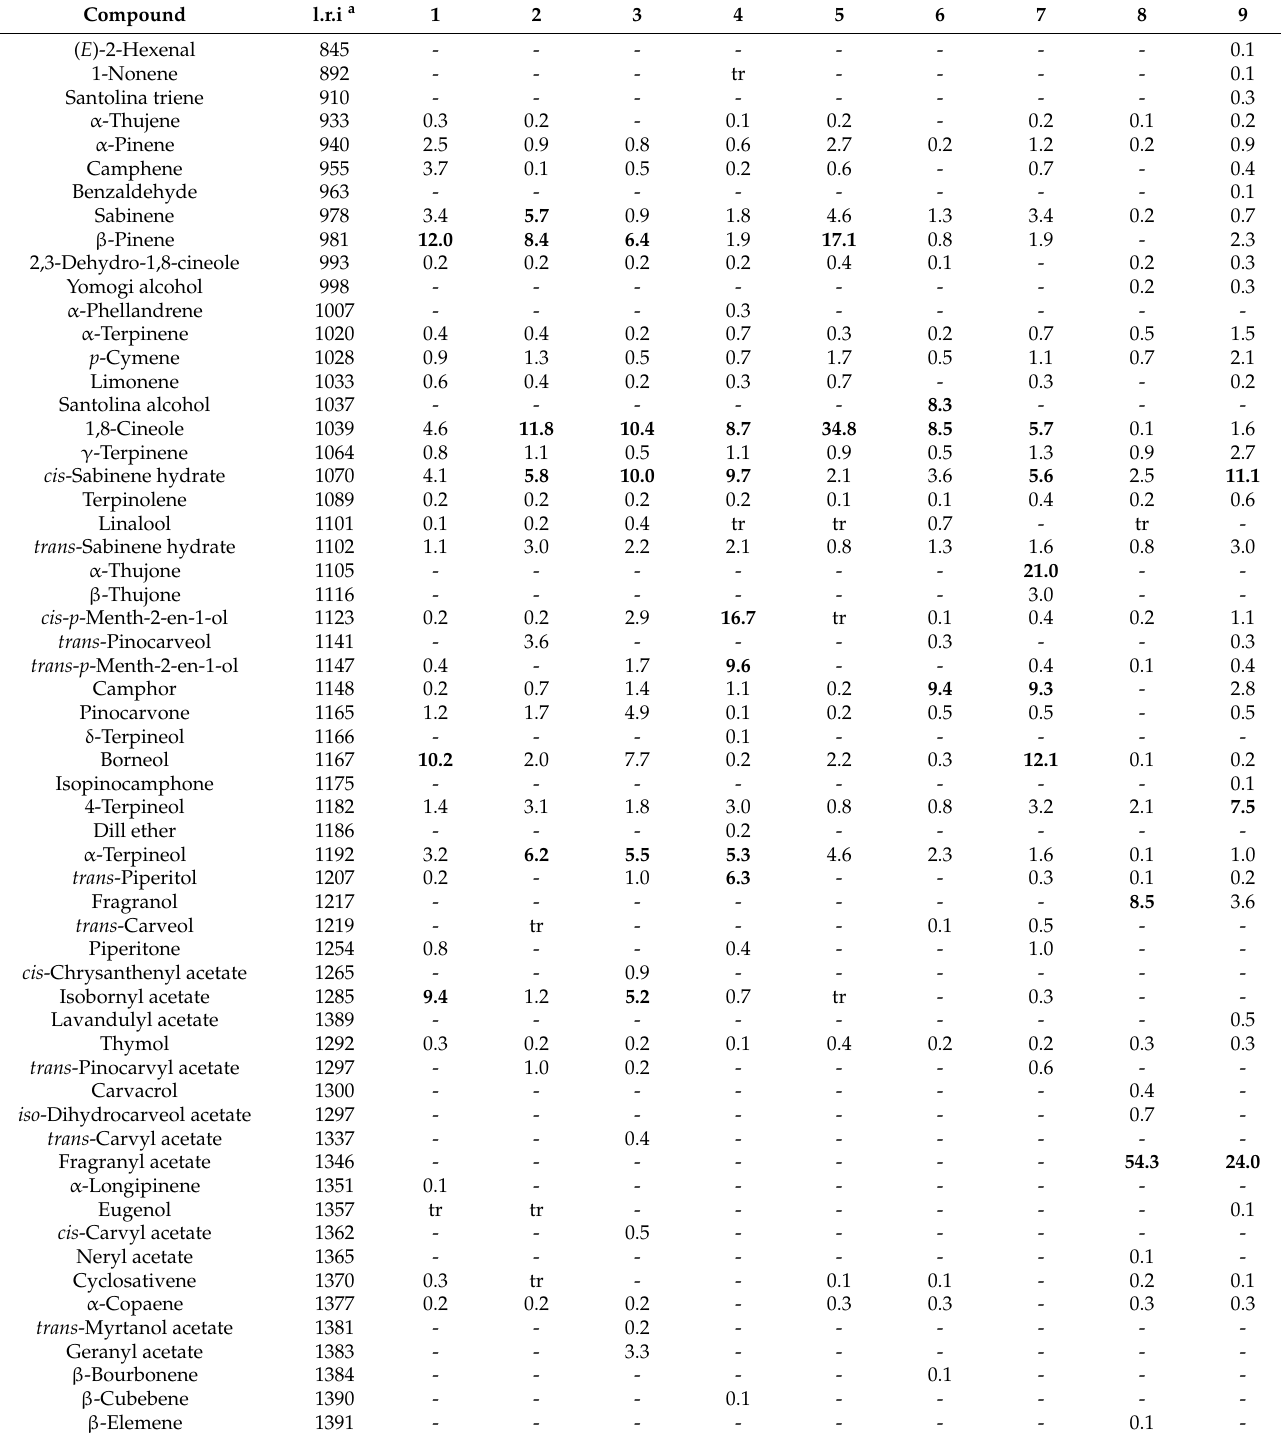
Table 1. Compositions of the leaf EOs obtained from the eight wild samples of Achillea ligustica (1–8) and a cultivated one